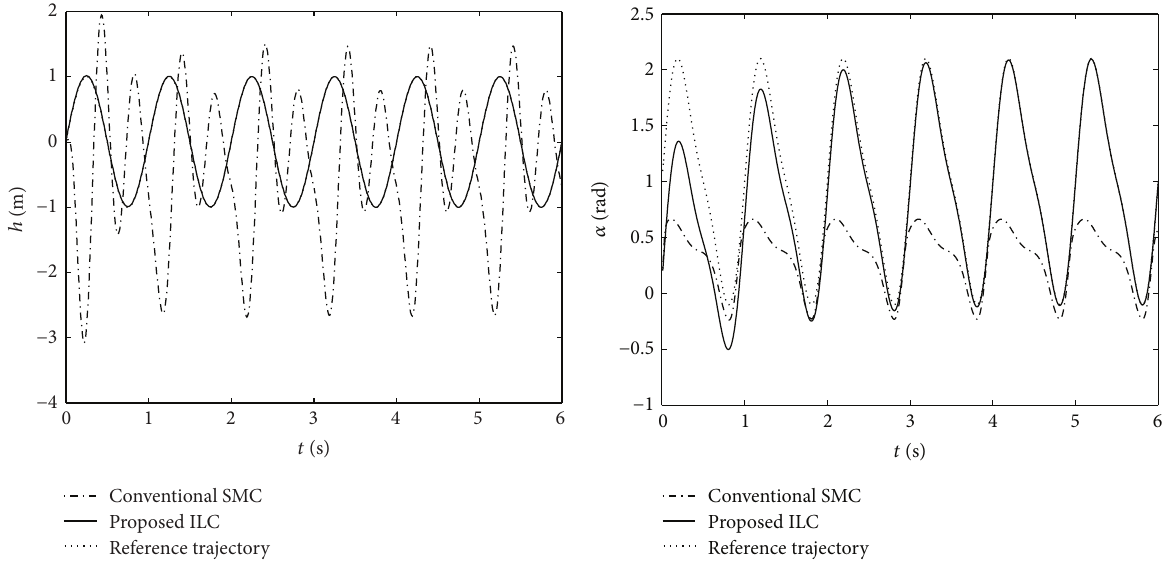
Figure 11: Comparison of the tracking response when 𝑥 ℎ,𝑑 = sin (2𝜋𝑡) , 𝑥 𝛼,𝑑 = 1 + sin (2𝜋𝑡) + 0.25 sin (4𝜋𝑡) .